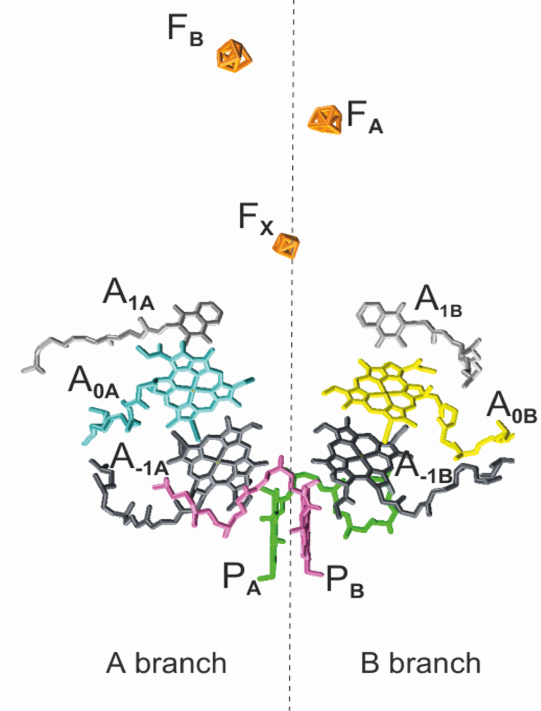
Figure 1. The arrangement of cofactors in the PS1 RC. Depicted in pink and green are the two central Chls, P B and P A , of the Chl a / Chl a ’ dimer. Furthermore, the RC contains two accessory Chl a (A − 1A and A − 1B ), two donor Chl a (A 0A and A 0B ), and two tightly associated phylloquinones (A 1A and A 1B ). Finally, there are three iron–sulfur [4Fe − 3S] clusters (F X , F A , and F B ) which function as terminal intrinsic electron acceptors. Both the A and B branches participate in electron transfer, with the relative activ- ity depending mainly on the organism and the reduction conditions. PDB entry 2WSC (Amunts et al.,